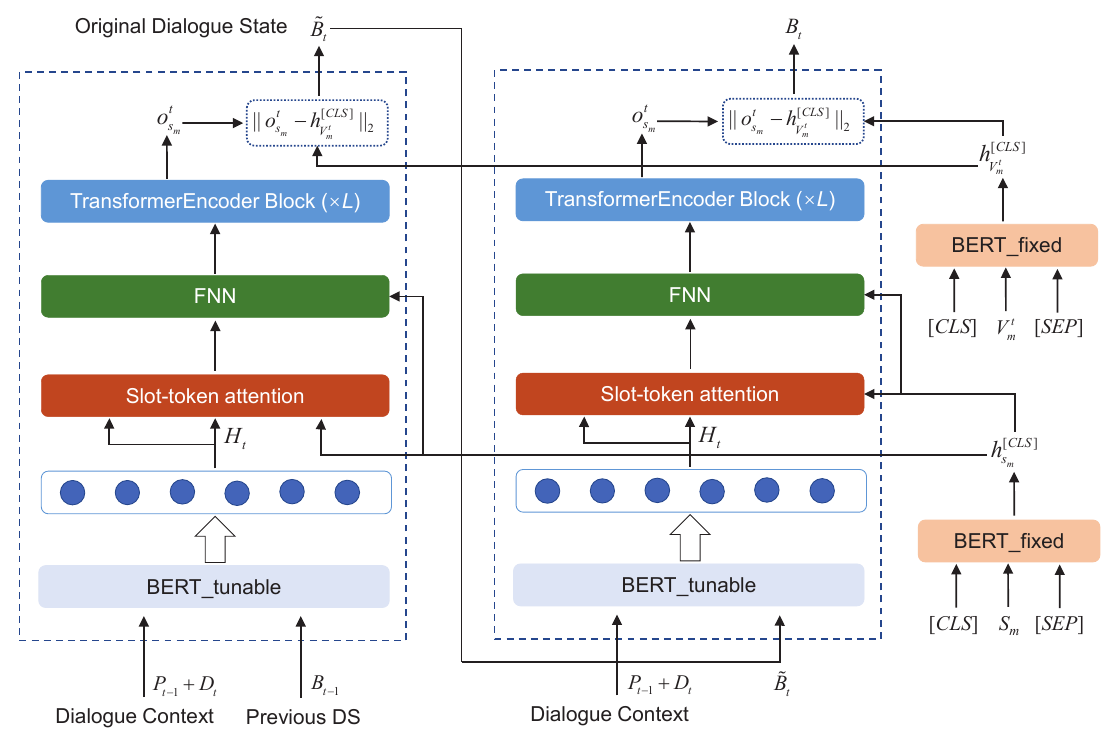
Figure 3. The overview of RSP-DST. BERT_tunable indicates that we will fine-tune the parameters of the BERT-base in the process of training. D t denotes the current dialogue context composed of the system response and the user utterance, and P t − 1 represents dialogue history. The input sequence at turn t is [ CLS ] ⊕ P t − 1 ⊕ B t − 1 ⊕ [ SEP ] ⊕ D t ⊕ [ SEP ] . BERT_fixed is utilized to encode values and slots, freezing the parameters in the training